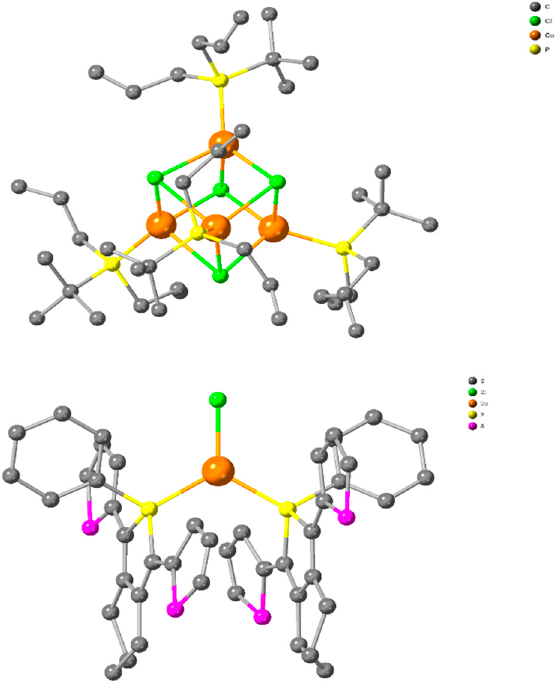
Figure 1. Novel tetramer copper(I) complexes containing diallylphosphine ligands. Compound 5 ( upper ) Compound 6 ( lower ).